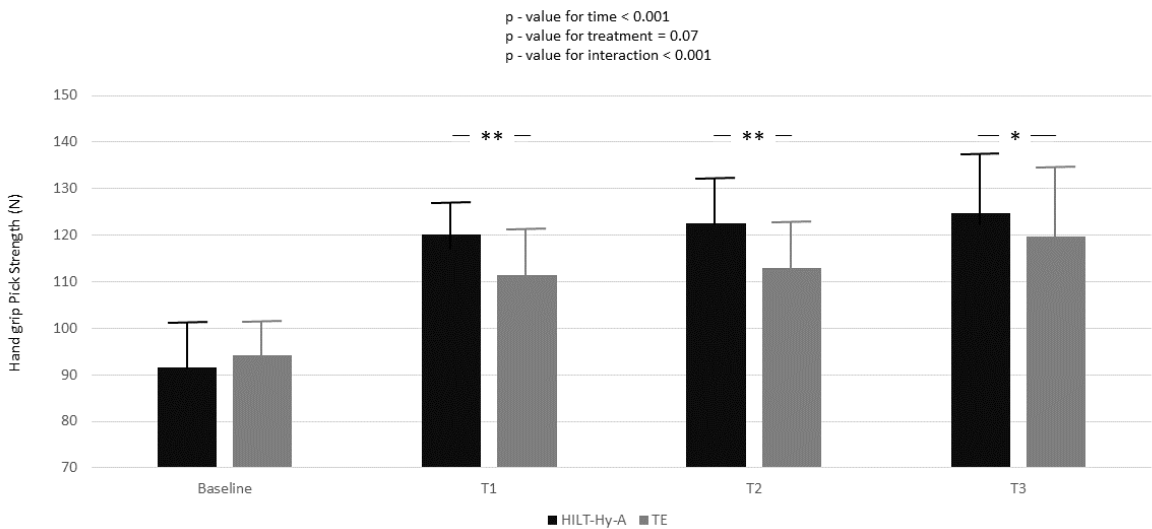
Figure 1. Handgrip peak strength variation according to time and treatment; black box represents high-intensity laser therapy plus hyaluronic acid (HILT + Hy-A) group, whereas grey box represents therapeutic exercise (TE). Results for the linear mixed model analysis (p-values for time, treatment, and interaction of time for treatment); Bonferroni adjustment for multiple comparisons were also applied between follow-ups of study compared to baseline; *: p < 0.05; **: p < 0.001. In the HILT + Hy-A group, the peak strength significantly increased compared to the TE group in all follow-ups (baseline-T1: 11.21 ± 1.89; p < 0.001; baseline-T2: 12.06 ± 2.94; p < 0.001; baseline-T3: 7.57 ± 3.26; p = 0.02). Nearly one- quarter (ρ = 24.5, Supplementary Table S1, Model A) of the total variation in peak strength was attributable to differences between patients. Moreover, from the unconditional means model, 84% of unexplained residual in the variation of peak strength (Model A: 210.81 ± 18.49 Nw) was associated with linear time (Model B) and 87% with the interaction between time and treatment (Model C). Model goodness increased (AIC decreased between models) with model com- plexity. Mean strength increased during the study period in both groups, and again a multiplicative effect was demonstrated for the interaction between treatment and time ( p < 0.001) (Figure 2).